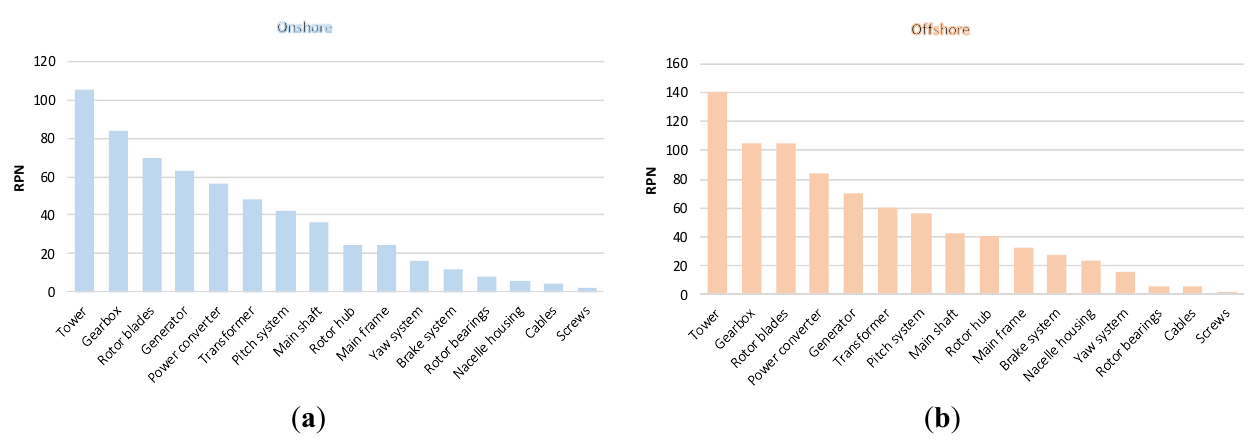
Figure 6. RPN values for the sixteen sub-assemblies of ( a ) onshore and ( b ) offshore wind